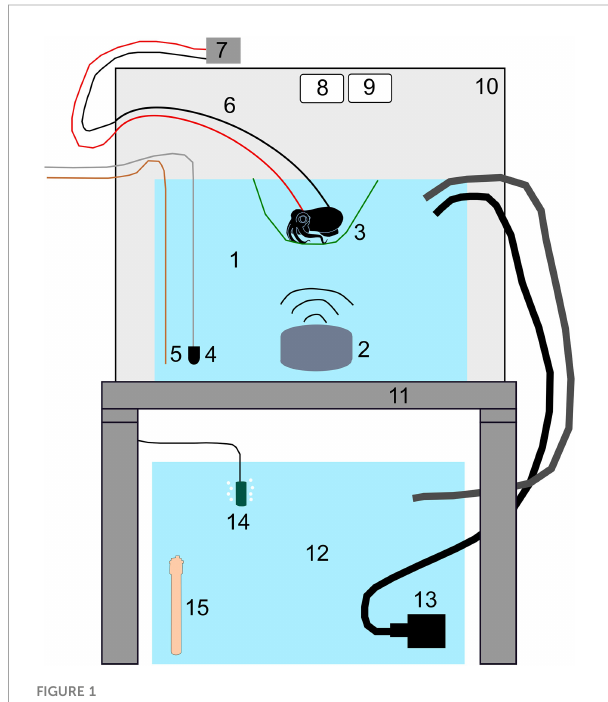
FIGURE 1 AEP experimental tank setup (not to scale). 1: Experimental tank; 2: Underwater speaker (Lubell Labs UW-30); 3. Mesh sling with animal suspended 4cm below water surface; 4: Hydrophone (B&K 8103); 5. Ground for experimental tank; 6. Recording and reference electrodes; 7. Headstage (Dagan); 8. Camera (Thorlabs); 9. IR light; 10. Acoustic isolation chamber; 11. Vibration isolation table (TMS Vibration Control); 12. Sump tank; 13. Pump and associated tubing; 14. Bubbler; 15.